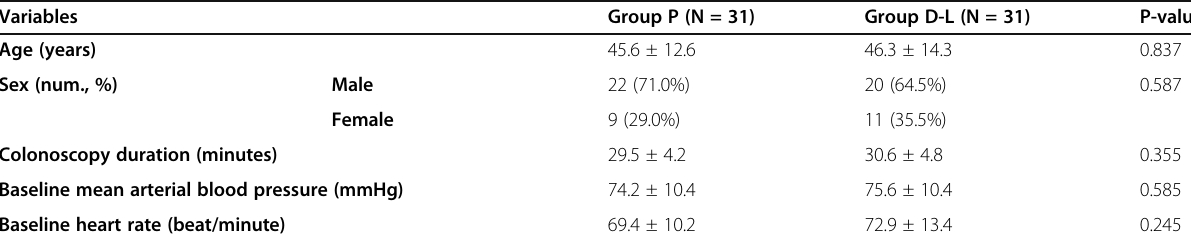
Table 1 Patients ’ demographics and baseline data